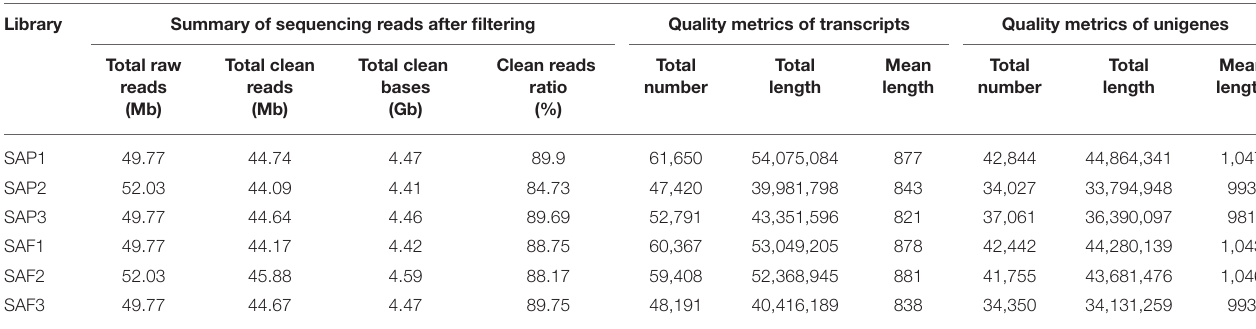
TABLE 1 | Categorization and abundance of